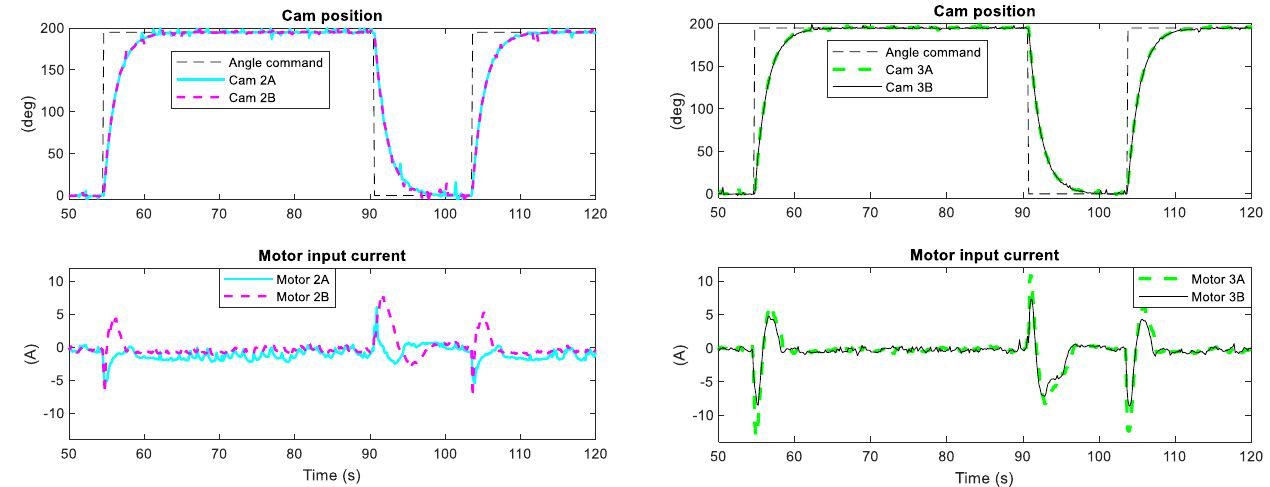
Figure 15. Performance of the system operating with two bearers; the second bearer (B2) and the third bearer (B3) at double actuation mode.